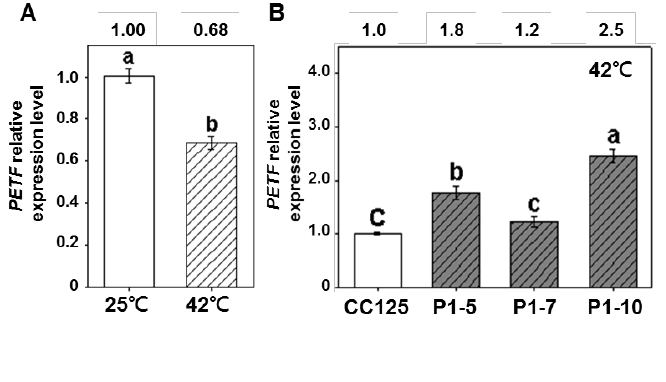
Figure 5. Comparison of PETF gene expression level under normal and heat-stress conditions. ( A ) The relative expression level of PETF transcripts of non-transgenic (CC125) under control (25 °C, blank columns) and heat treatment (42 °C, twilled columns); ( B ) The PETF gene expression level from non-transgenic (CC125) and PETF -transgenic lines (P1-5, P1-7 and P1-10) were specifically amplified with primers 2201F and PETF-R by qPCR. As shown above the column, the relative expression level of PETF transcripts